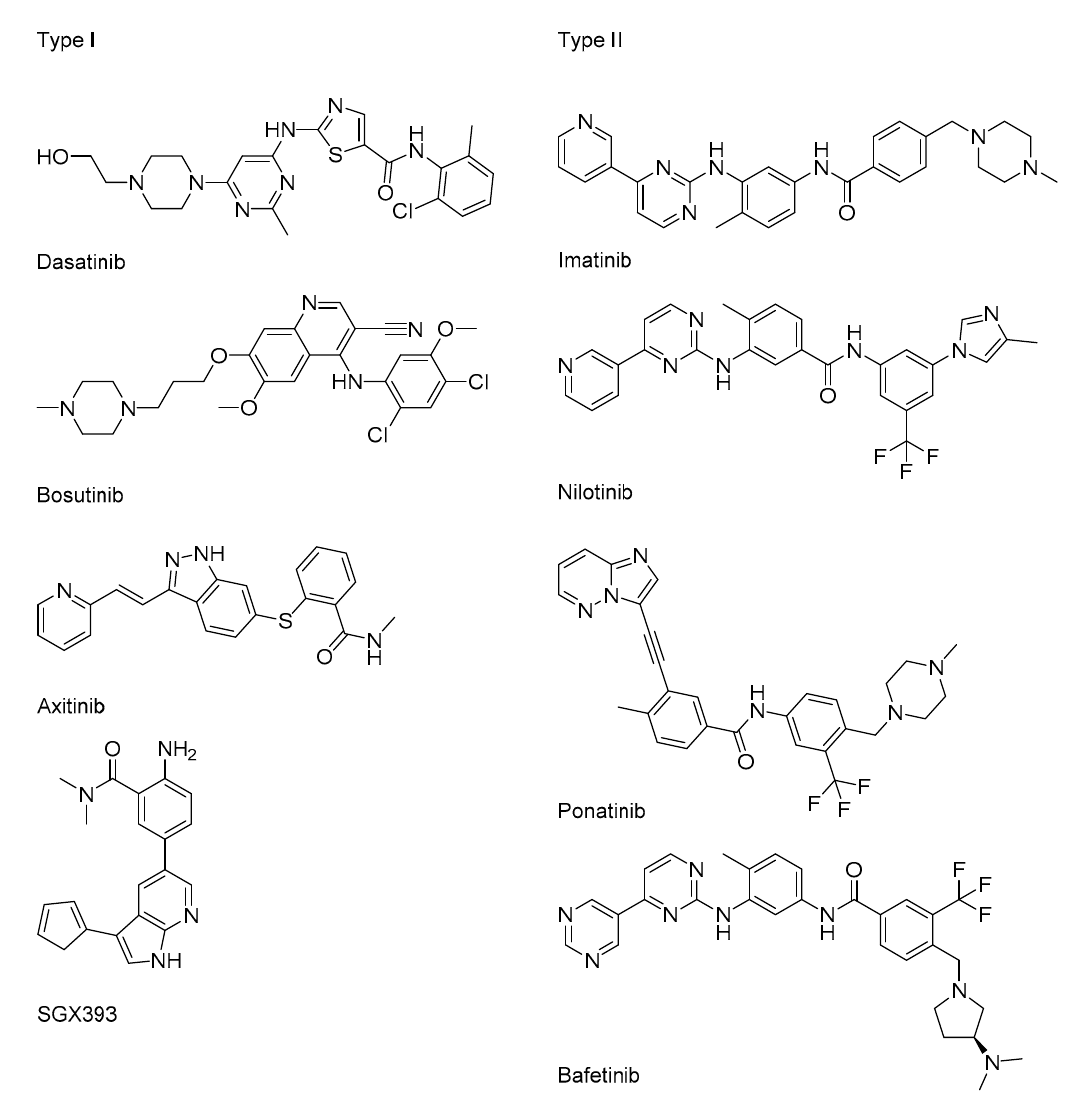
Figure 5. Bcr-Abl ATP competitive inhibitors.